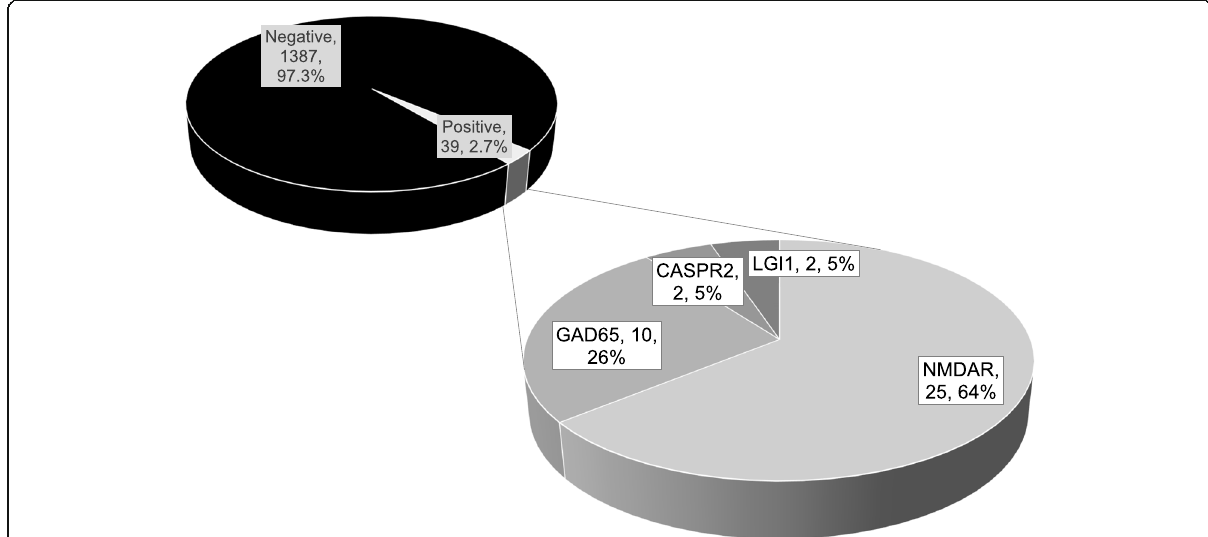
Fig. 1 Frequency of positive results from the testing of 1426 patients < 18 years in the years 2011 – 2015 in the antibody laboratory of the Epilepsy Center Bethel. For each patient, only the earliest sample(s) were included. Absolute numbers and percentages are indicated in the